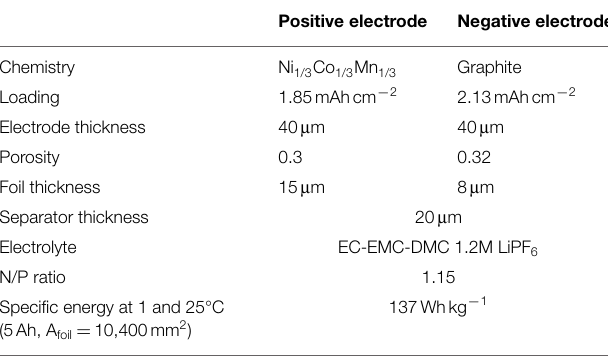
TABLE 1 | Baseline cell internal structure design parameters .